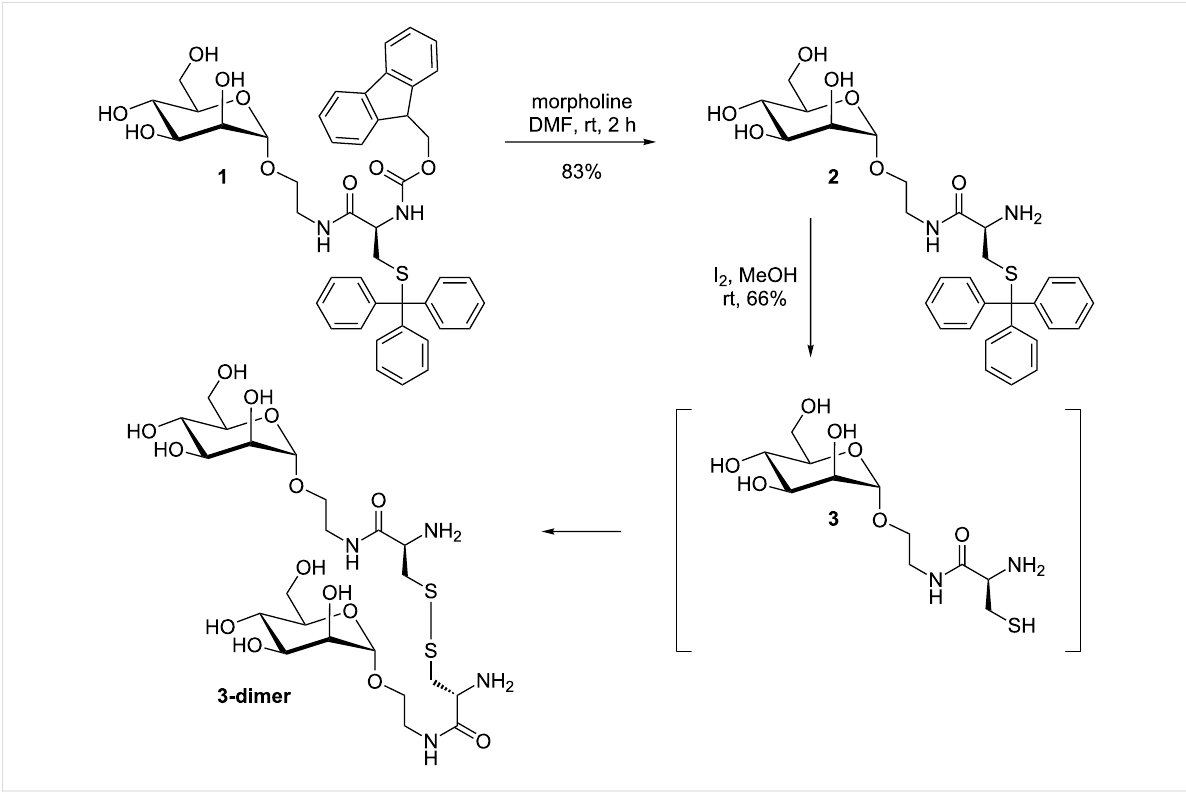
Scheme 1: Synthesis of glycoamino acid derivative 3 and its dimer, from the known mannopyranoside 1 .